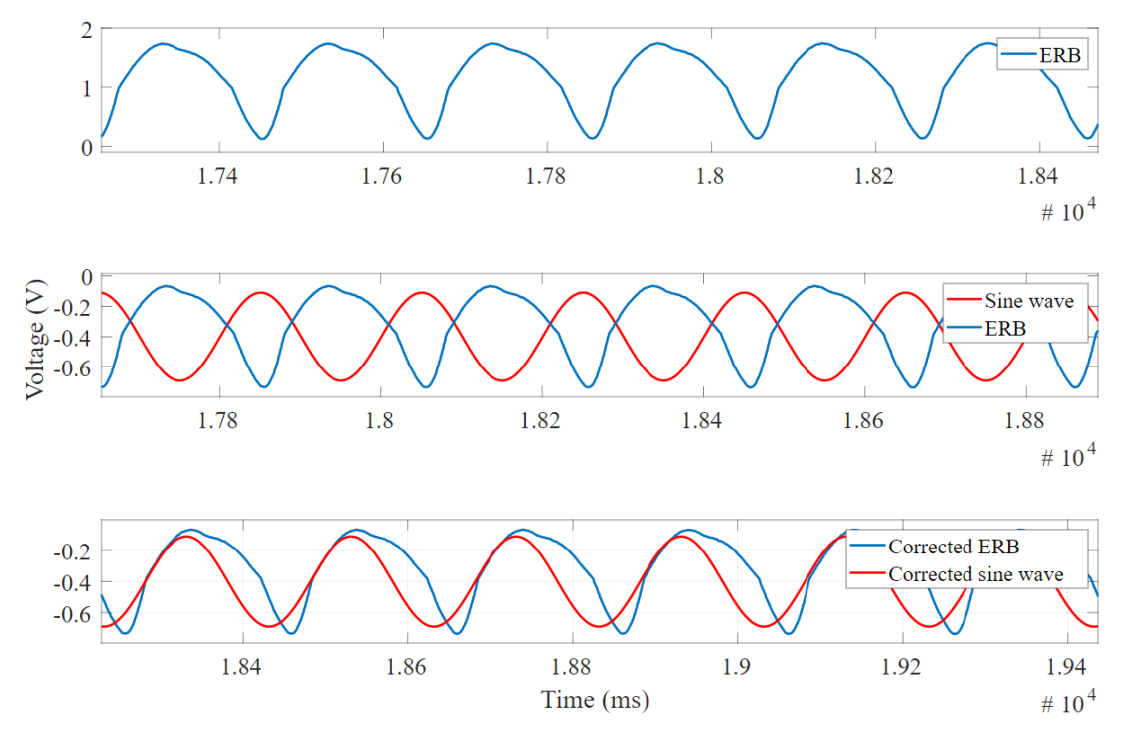
Figure 10. The pre-processing steps performed on the signal to apply cross